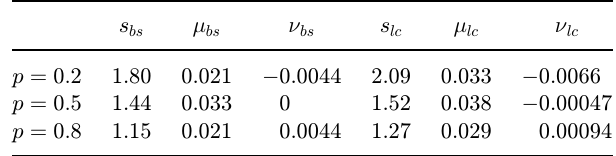
Table 3. Parameters of the distribution of erythrocytes in shape in a shear °ow with the shear rate of 306.5 s (cid:4) 1 , and the level of light intensity at the isointensity line equal to 220 (in units of Fig. 6). The normalized light intensity at the iso- intensity line f 0 ¼ 0 : 012. The number \ p " stands for the pro- portion of non-deformable red blood cells in a sample of blood. The experiment was performed with the blood of rat 1.